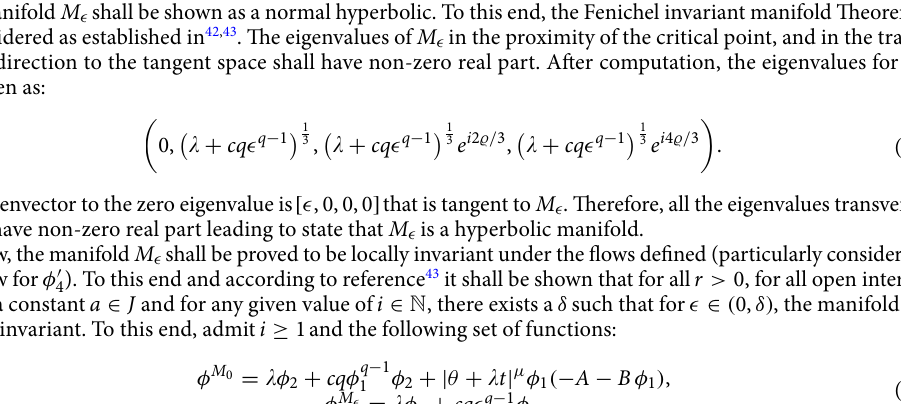
Figure 4. Complex domain (real part—horizontal axis, imaginary part—vertical axis) for (cid:31) = − 100 (left) and (cid:31) = − 1000 (right). Evolution of R ( s ) roots in the complex domain considering � 1 < ǫ → 0 and | y | µ that at least one root has Re ( s ) > 0